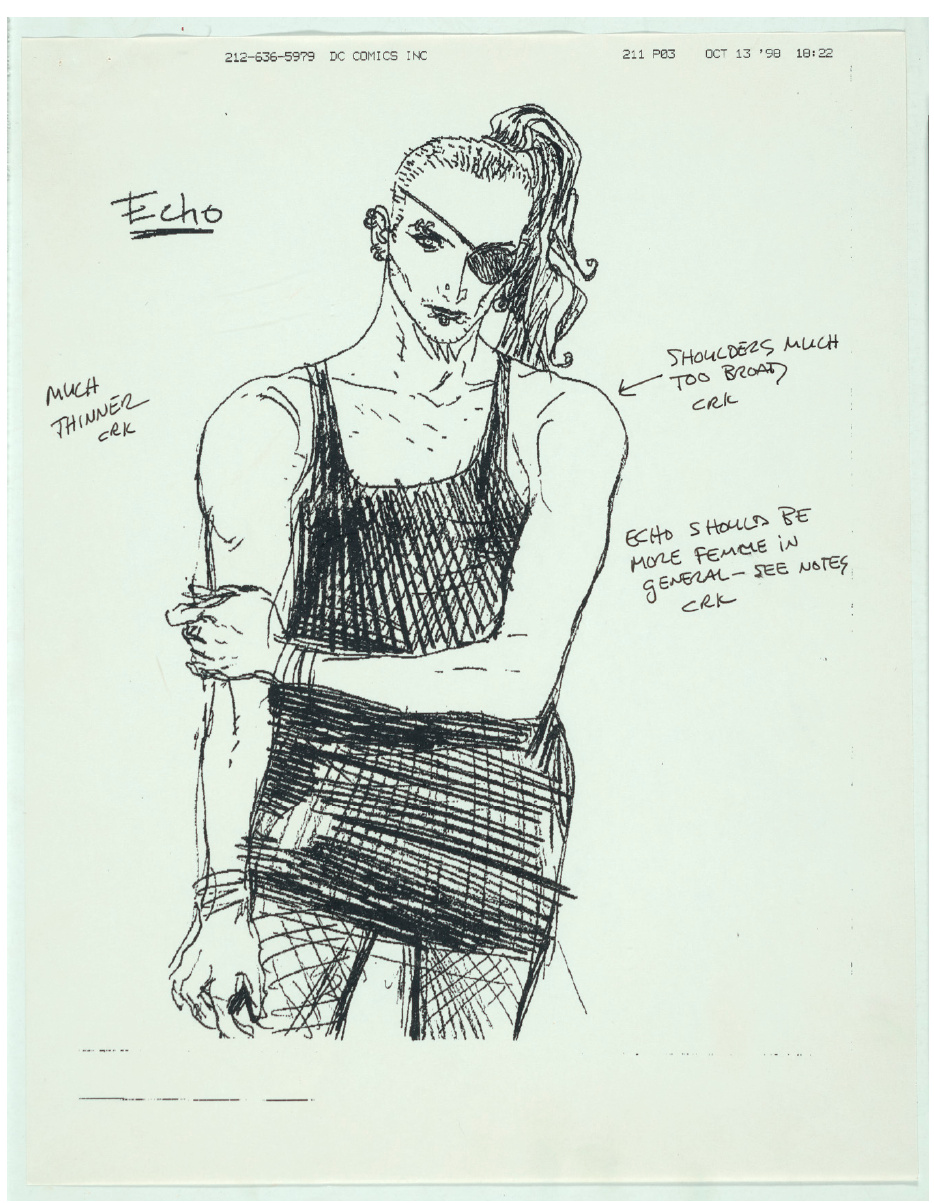
Figure 1. Early draft sketch of Echo with Kiernan’s handwritten remarks.